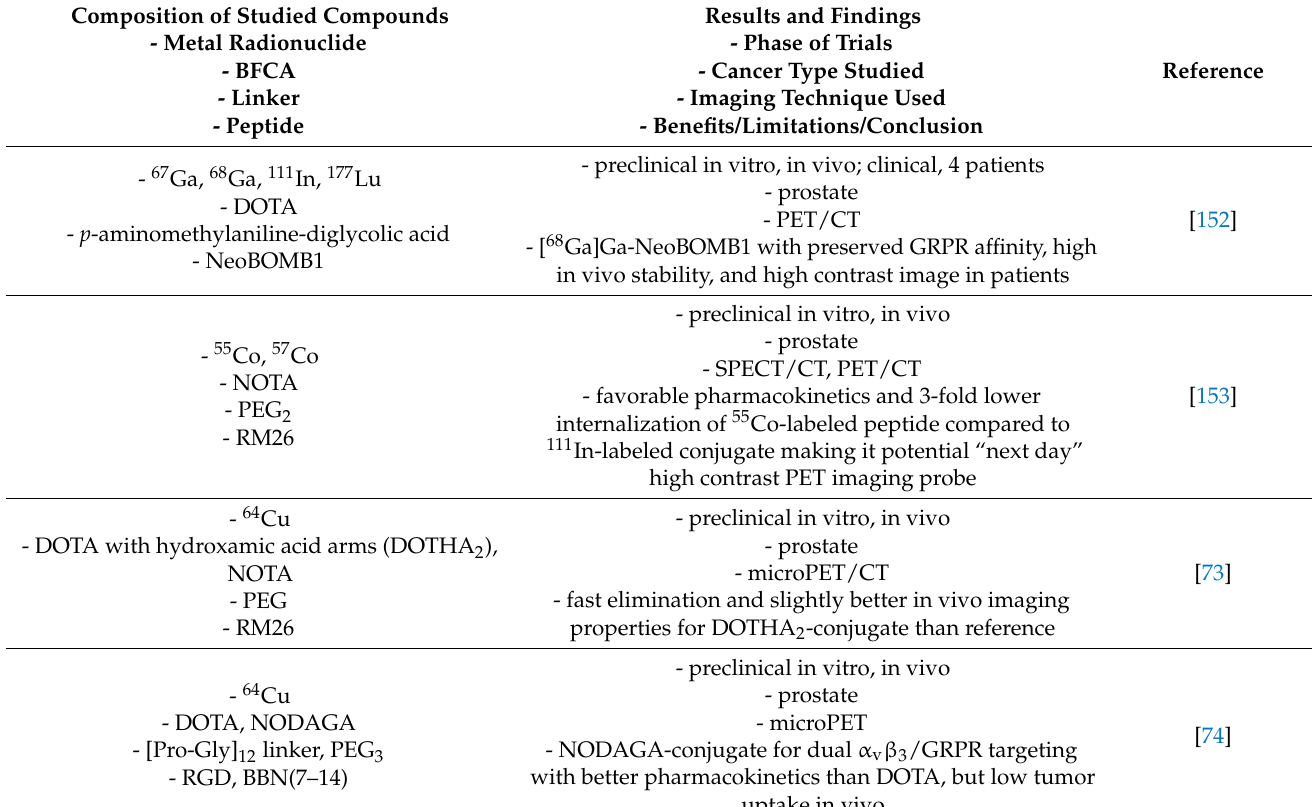
Table 8. Summary of radiolabeled bombesin analogues for GRPR-positive tumor imaging over past 3 years. Composition of Studied Compounds